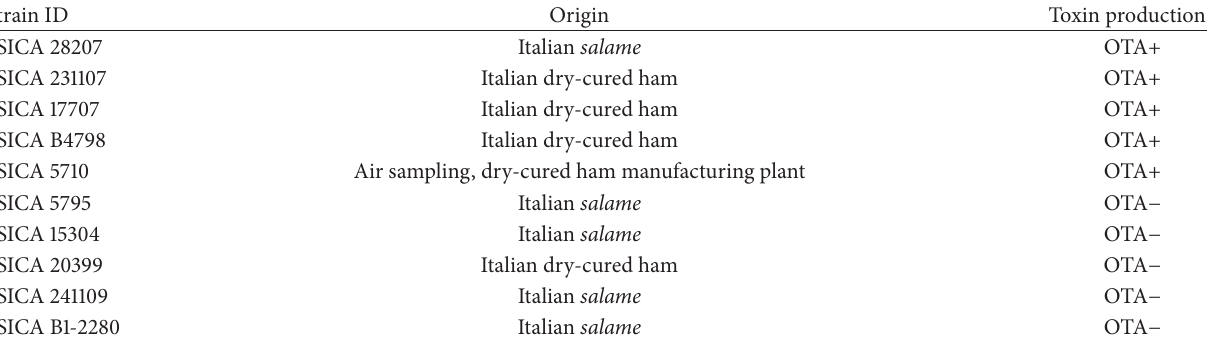
Table 1: List of Penicillium nordicum strains used in this study.